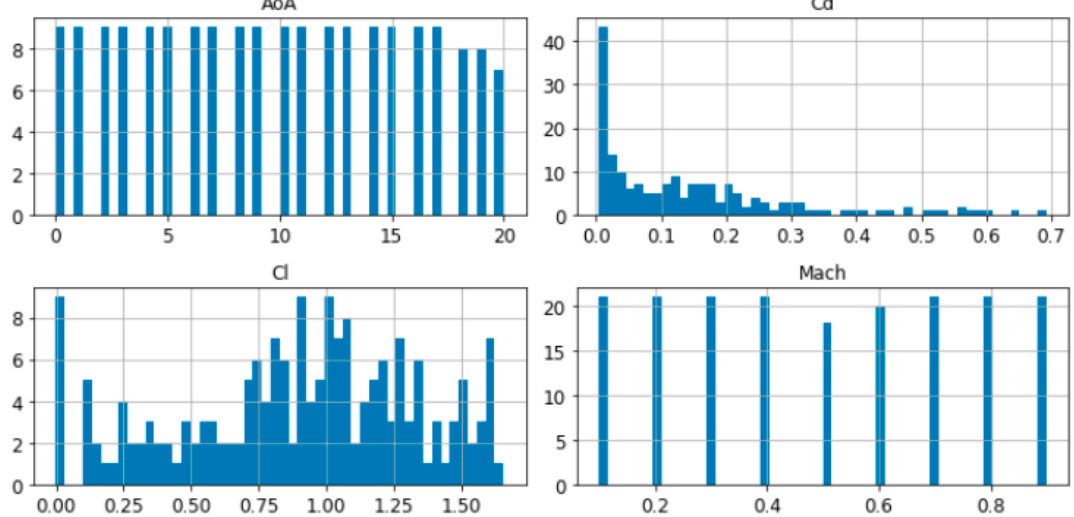
Figure 2. Histograms of the variables in the NACA0012 database (X-axis shows the value of the parameter while Y-axis shows the number of occurrences of that value in the database).